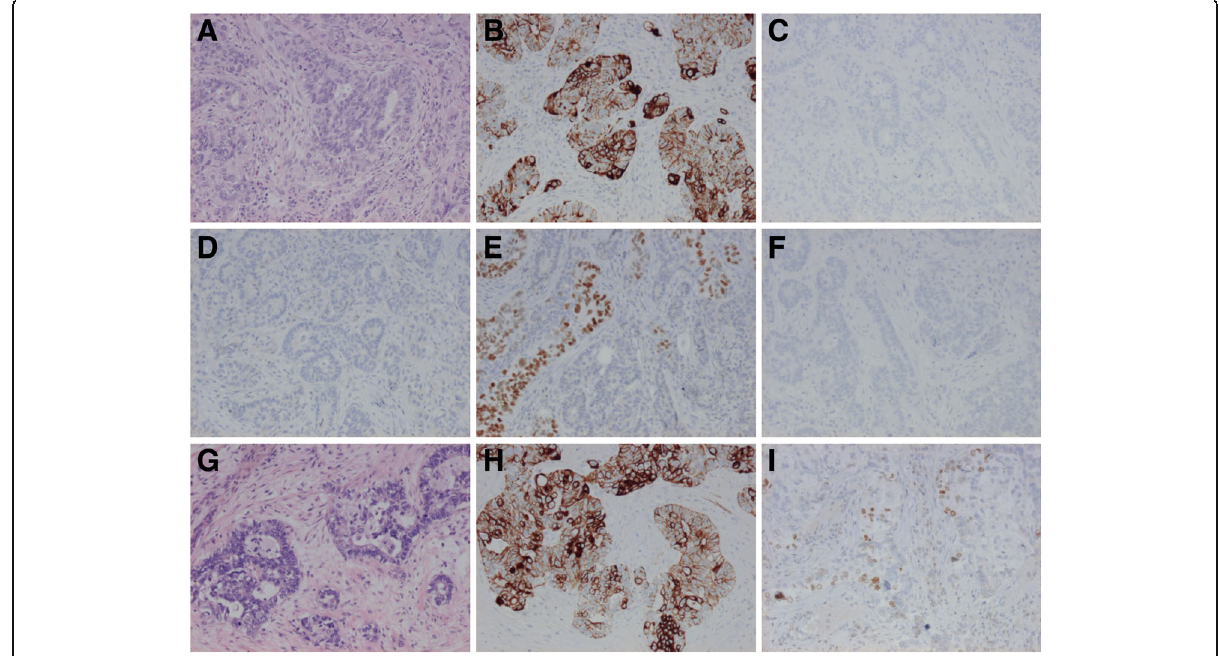
Fig. 1 Case 1. Metastases of rectal cancer to the lung and liver with atypical immunohistochemical profile. a - f The metastasis to the lung. a HE, ( b ) CK7, ( c ) CK20, ( d ) CDX2, ( e ) TTF-1, ( f ) napsin A. g - i The metastasis to the liver. g HE, ( h ) CK7, ( i ) TTF-1. Note that CK20 and CDX2 were also negative in the metastasis to the liver (not shown). All images x10